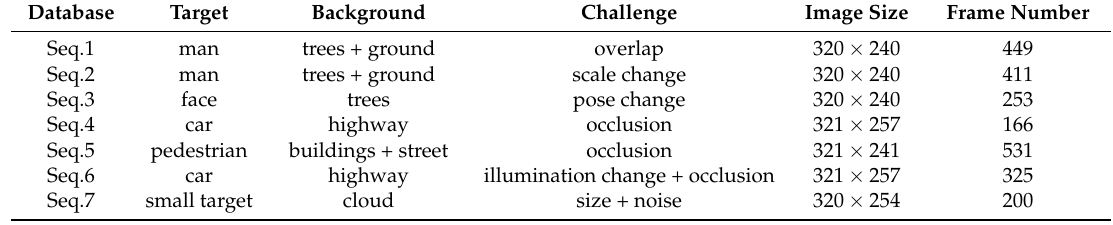
Table 1. Descriptions of the infrared sequences used in the experiments.